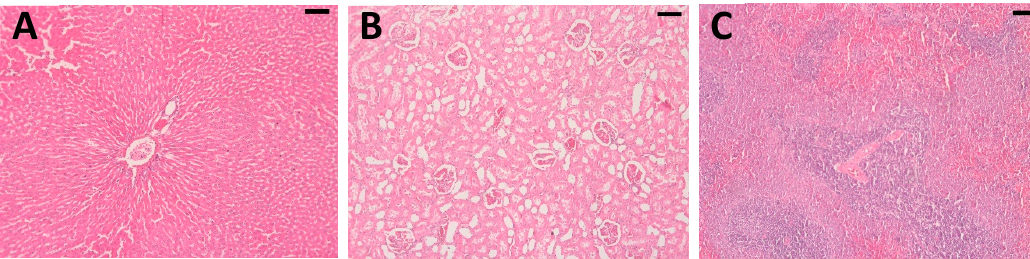
Figure 10. Exemplary histological sections of the liver ( A ), kidneys ( B ), and spleen ( C ) of EHA450 group. The images show no signs of ischemia, necrosis, cell injury and/or inflammation. (Hematoxylin-Eosin—HE stain, Bar = 100 μ m, 100×).